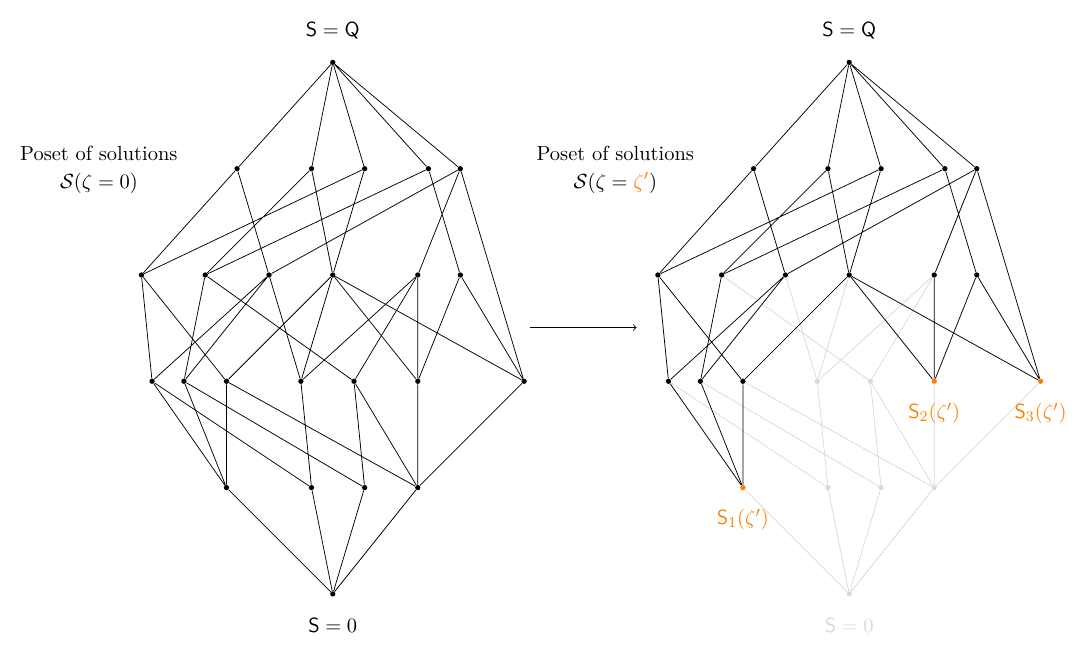
Figure 3 . The geometric deformations and RG flows of figure 2 are mirrored in the poset of solutions S ( ζ ) to the FI-Meson problem. When ζ = 0 , the poset S ( ζ ) has a unique minimal element S = 0 , meaning that there is no deformation. For generic values ζ = ζ 0 6 = 0 , the poset S ( ζ 0 ) can have several minima S i ( ζ 0 ) . These minima are in one-to-one correspondence with the singularities after deformation, using the subtraction